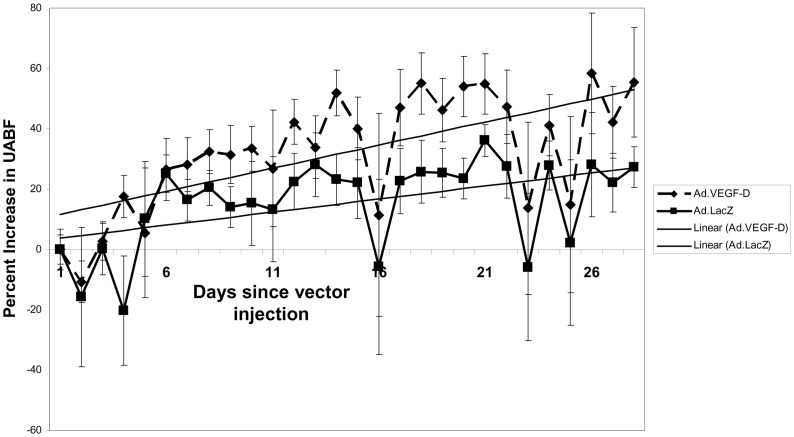
Changes in UABF after adenovirus vector injection.Graph showing the percentage increase in UABF from baseline (adjusted to 0) and gradients of percentage increase in UABF in Ad.VEGF-DΔNΔC and Ad.LacZ transduced UtAs from 5 pregnant sheep. Vector injection = Day 0; Error bars denote SEM.